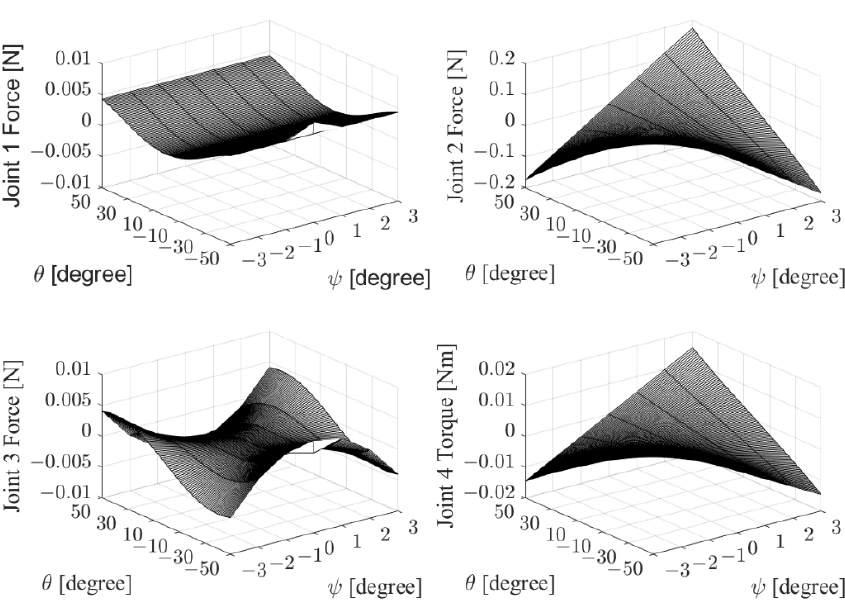
Figure 7. Force and torque analysis for FE movement.